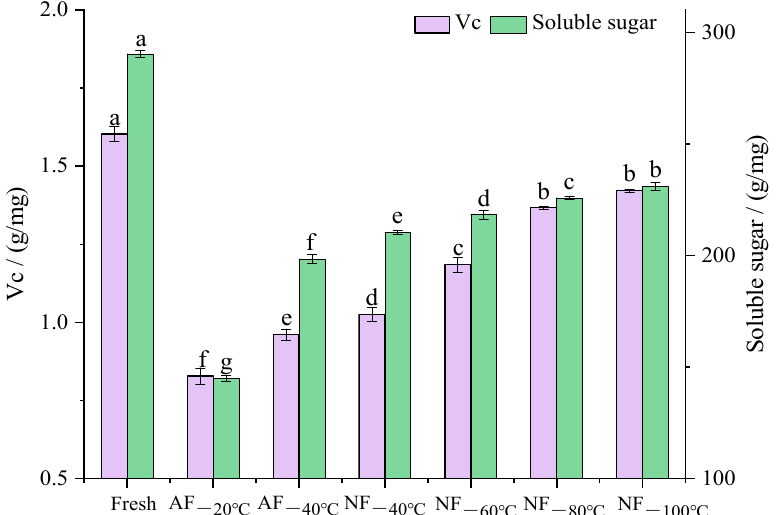
Figure 5. Effects of different freezing treatments on the Vc and soluble sugar of chestnut kernels. Note: In each column, different letters mean significant differences ( p < 0.05).